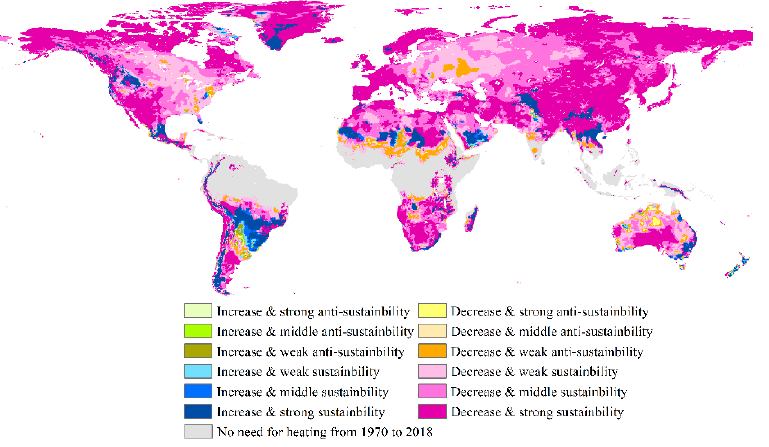
Figure 5. Types of trends in the past and future of global cooling degree days based on the Mann– Kendall test and Hurst exponent methods.